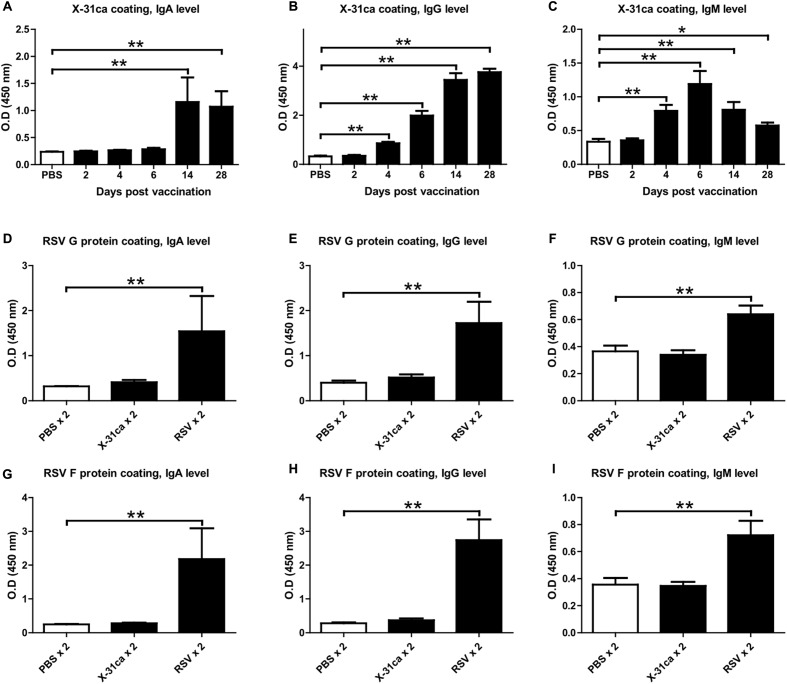
Antibodies from mice vaccinated with X-31ca. (A–C) Mice (n = 4 per group) were vaccinated with 106 PFU of X-31ca and then euthanized at days 2, 4, 6, 14, and 28 p.v. to collect BAL fluids and sera. ELISAs were performed by using 5 × 105 PFU/well of X-31ca and BAL fluids diluted 1:20 (A) or sera diluted 1:320 (B,C). (D–I) Mice (n = 4 per group) were infected with 106 PFU of X-31ca, RSV A2, or PBS as a negative control and then boosted with the same dose at 2-week intervals. ELISAs were conducted by using 50 ng/well of RSV G protein as the coating antigen and BAL fluids diluted 1:4 (D) or sera diluted 1:200 (E,F). ELISAs for RSV F protein (50 ng/well) were performed with BAL fluids diluted 1:4 (G) or sera diluted 1:400 (H,I). OD, optical density (∗P < 0.05, ∗∗P < 0.01 compared with the PBS control group).